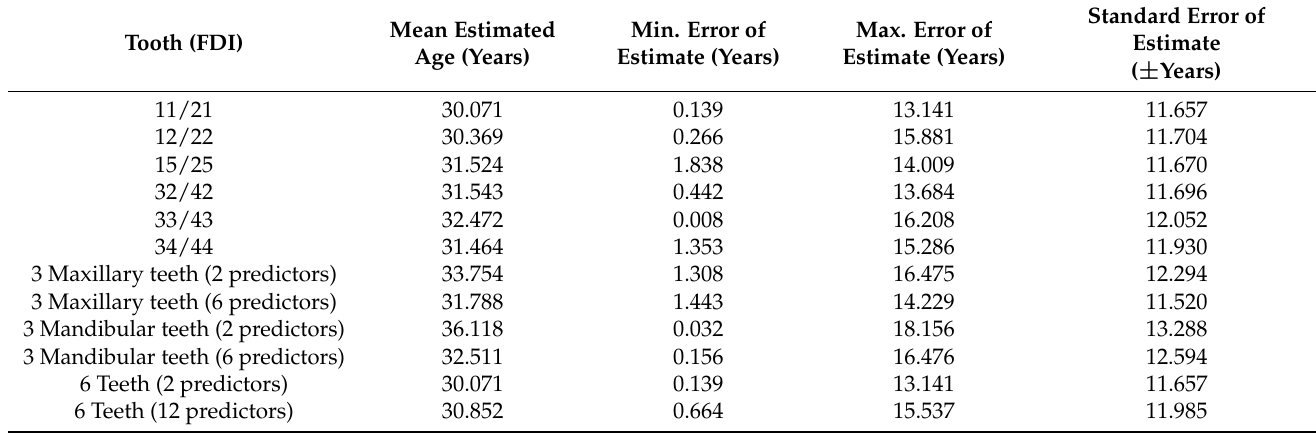
Table 7. Tests of the accuracy of age estimation methods using a validation sample of digital OPGs with known age a .